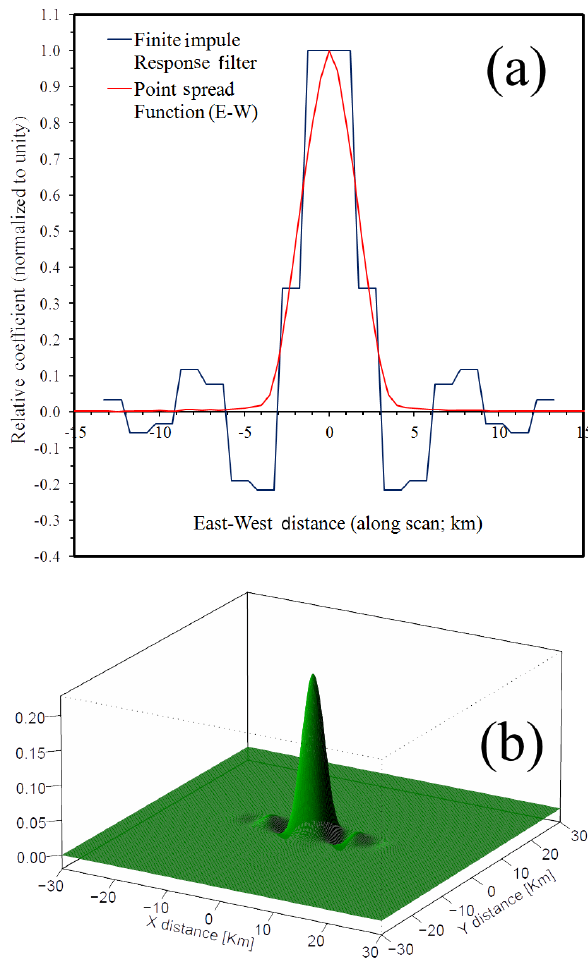
Figure 7. (a) The E–W point spread function of SEVIRI (at sub- satellite point) and the finite impulse response (FIR) function. The latter is applied to level 1.0 data before conversion to level 1.5. Both are shown here normalized to unity. Note the negative side lobes of the FIR filter. (b) Convolution of the FIR filter and the E–W and N–S SEVIRI point spread function (PSF) used in the simulation of active fire observations (Fig. 6).